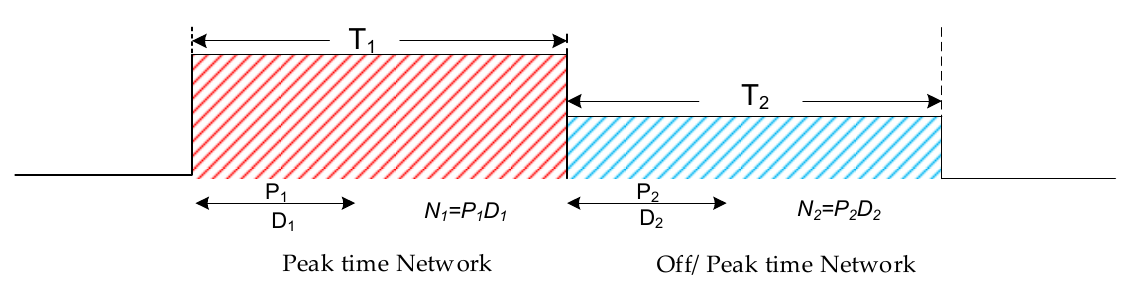
Figure 4. Amount of data over time: proposed asynchronous period.